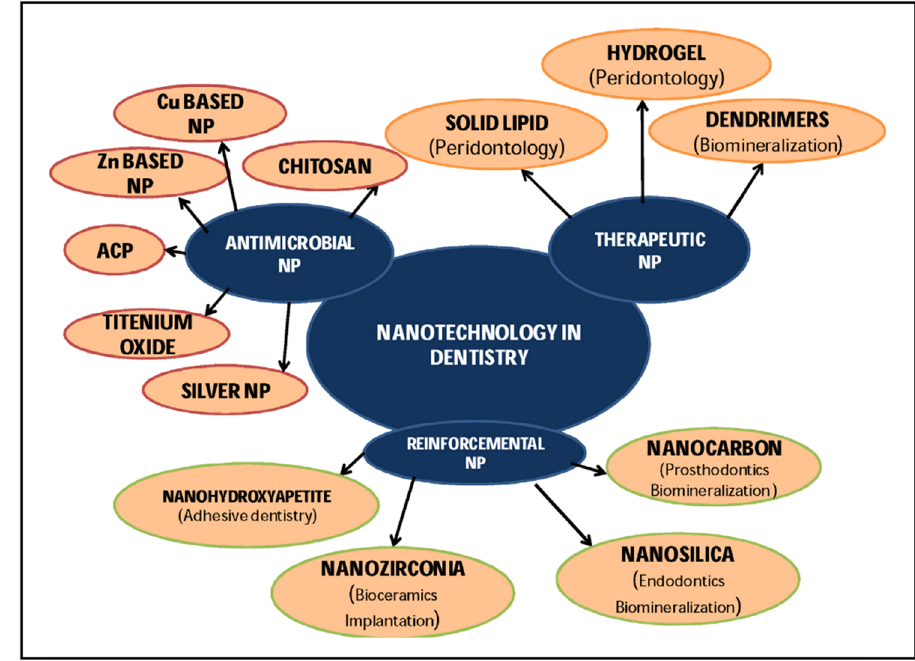
Figure 22: Applications of nanoparticle coating in dentistry [ 22 ] . Copyright 2018, Elsevier ™